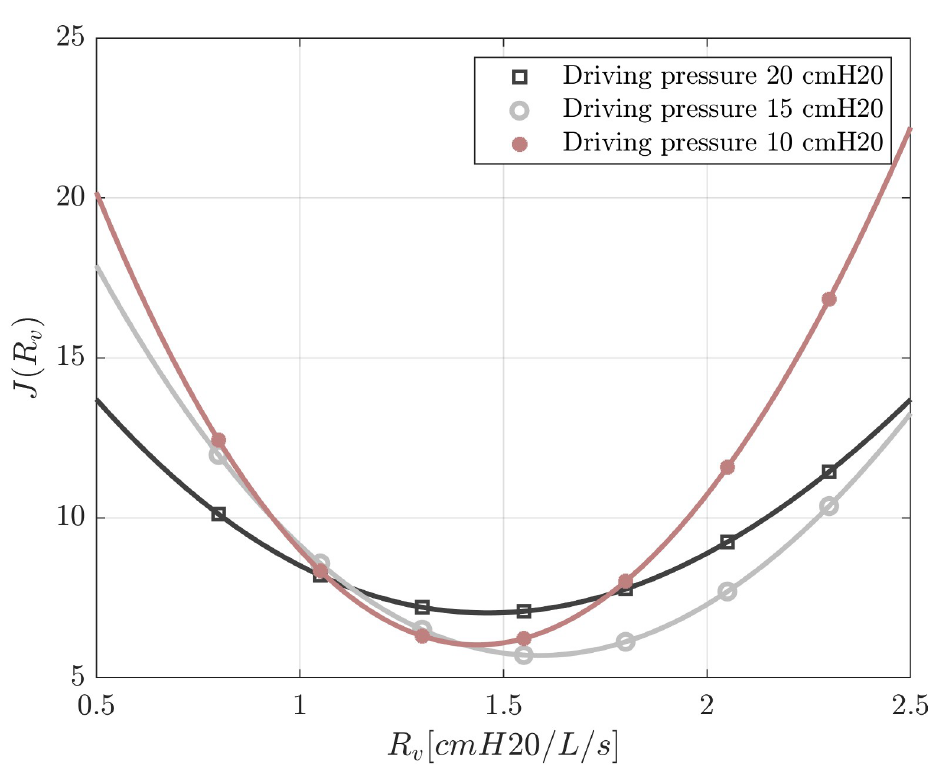
Fig 14. Estimation of ventilator resistance by minimizing functional